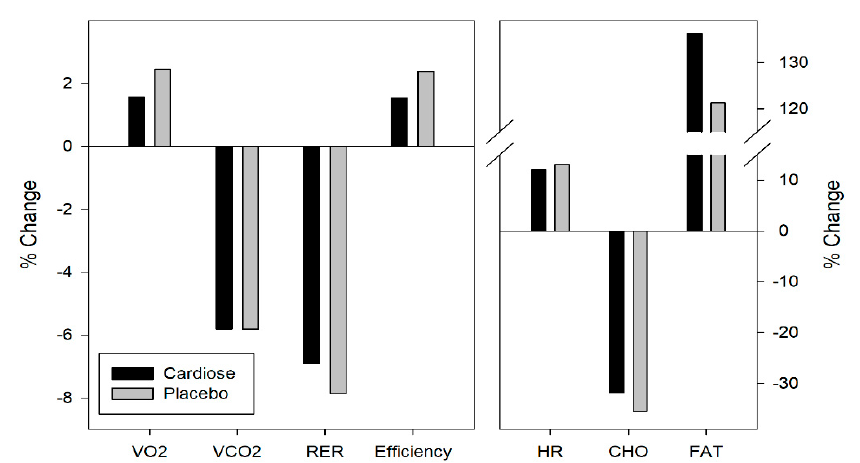
Figure 4. Changes in cardiorespiratory and metabolic parameters between the rectangular test (VT1 intensity during 20 min) carried out before and after the repeated all-out sprints test. 340